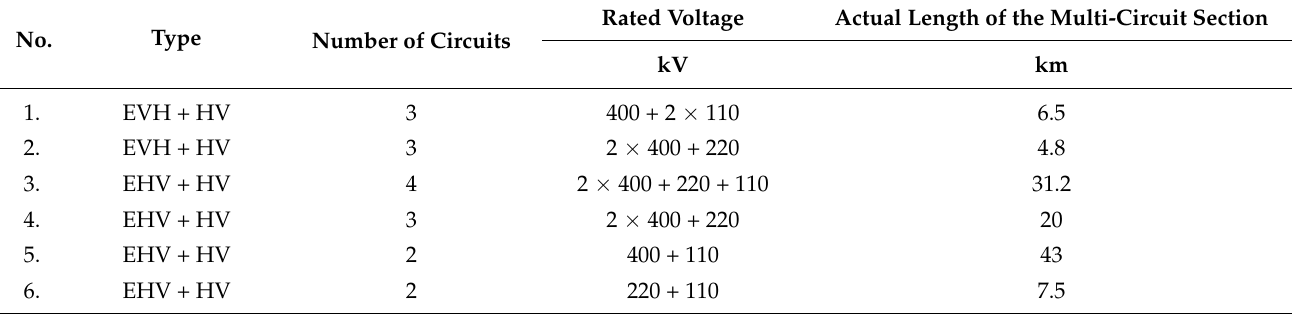
Table 3. Multi-circuit and multi-voltage lines for HV and EHV in the Polish power system